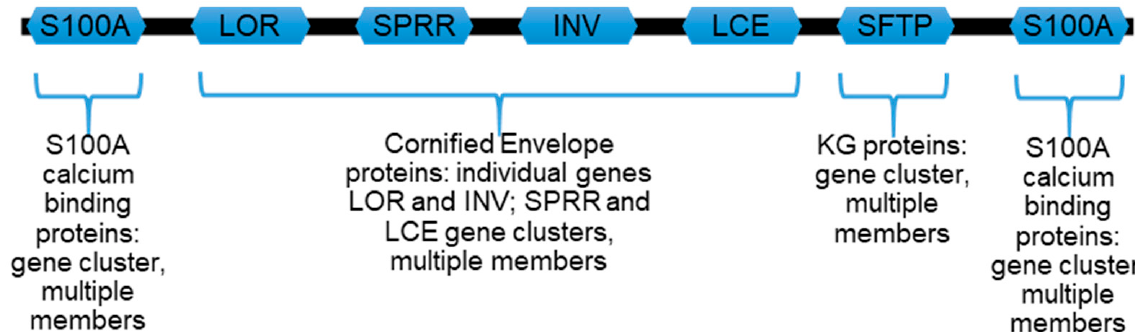
Figure 2. Schematic representation of human epidermal differentiation complex (EDC) on chromosome 1q21. The EDC is contiguous, as shown, but the chromosome region and genes/gene families are not to scale. S100A calcium-binding protein genes in up- and downstream clusters are different members of that family. CE, cornified envelope gene proteins: LOR, loricrin; SPRR, small proline-rich region (SPRR) proteins including cornifin-A and B; INV, involucrin; LCE, late cornified envelope proteins. KG, keratohyalin granule S100-fused type proteins (SFTPs): PF1, profilaggrin; HRNR, hornerin; PF2, profilaggrin 2; RPTN, repetin; CRNN, cornulin; TCHH, trichohyalin; TCHHL1, trichohyalin-like 1.